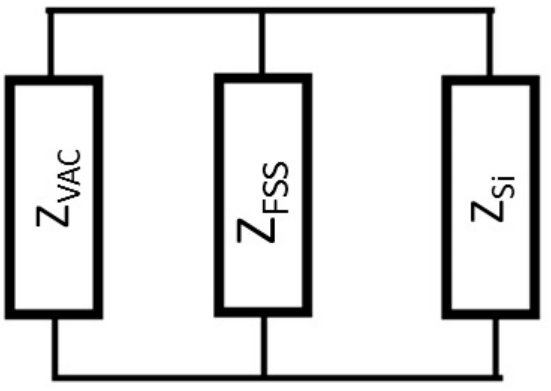
Figure 1. Equivalent diagram.